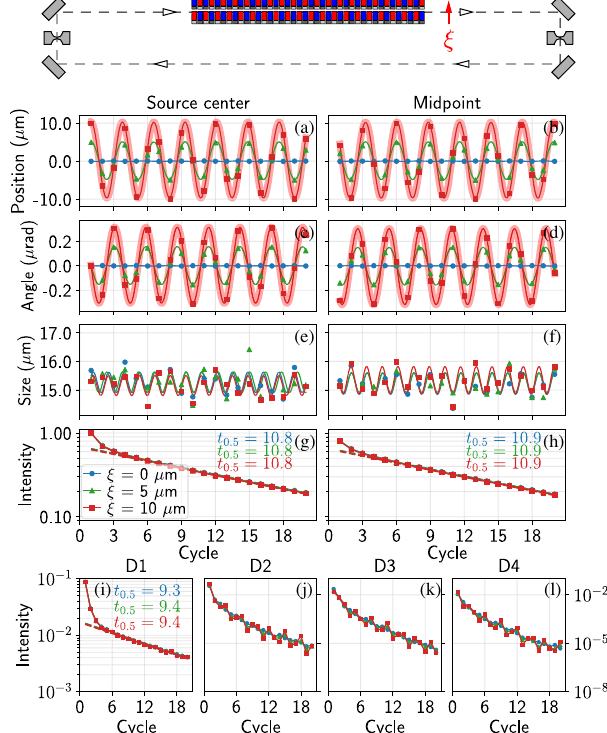
FIG. 20. Similar to Fig. 19, but with position error ξ at source.